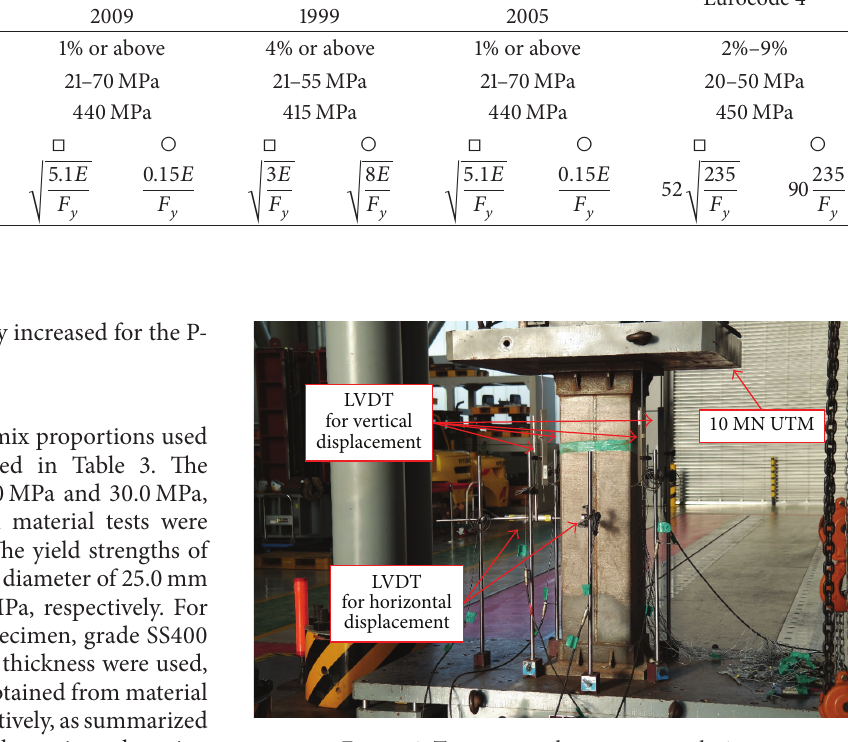
Figure 3: Test setup and measurement